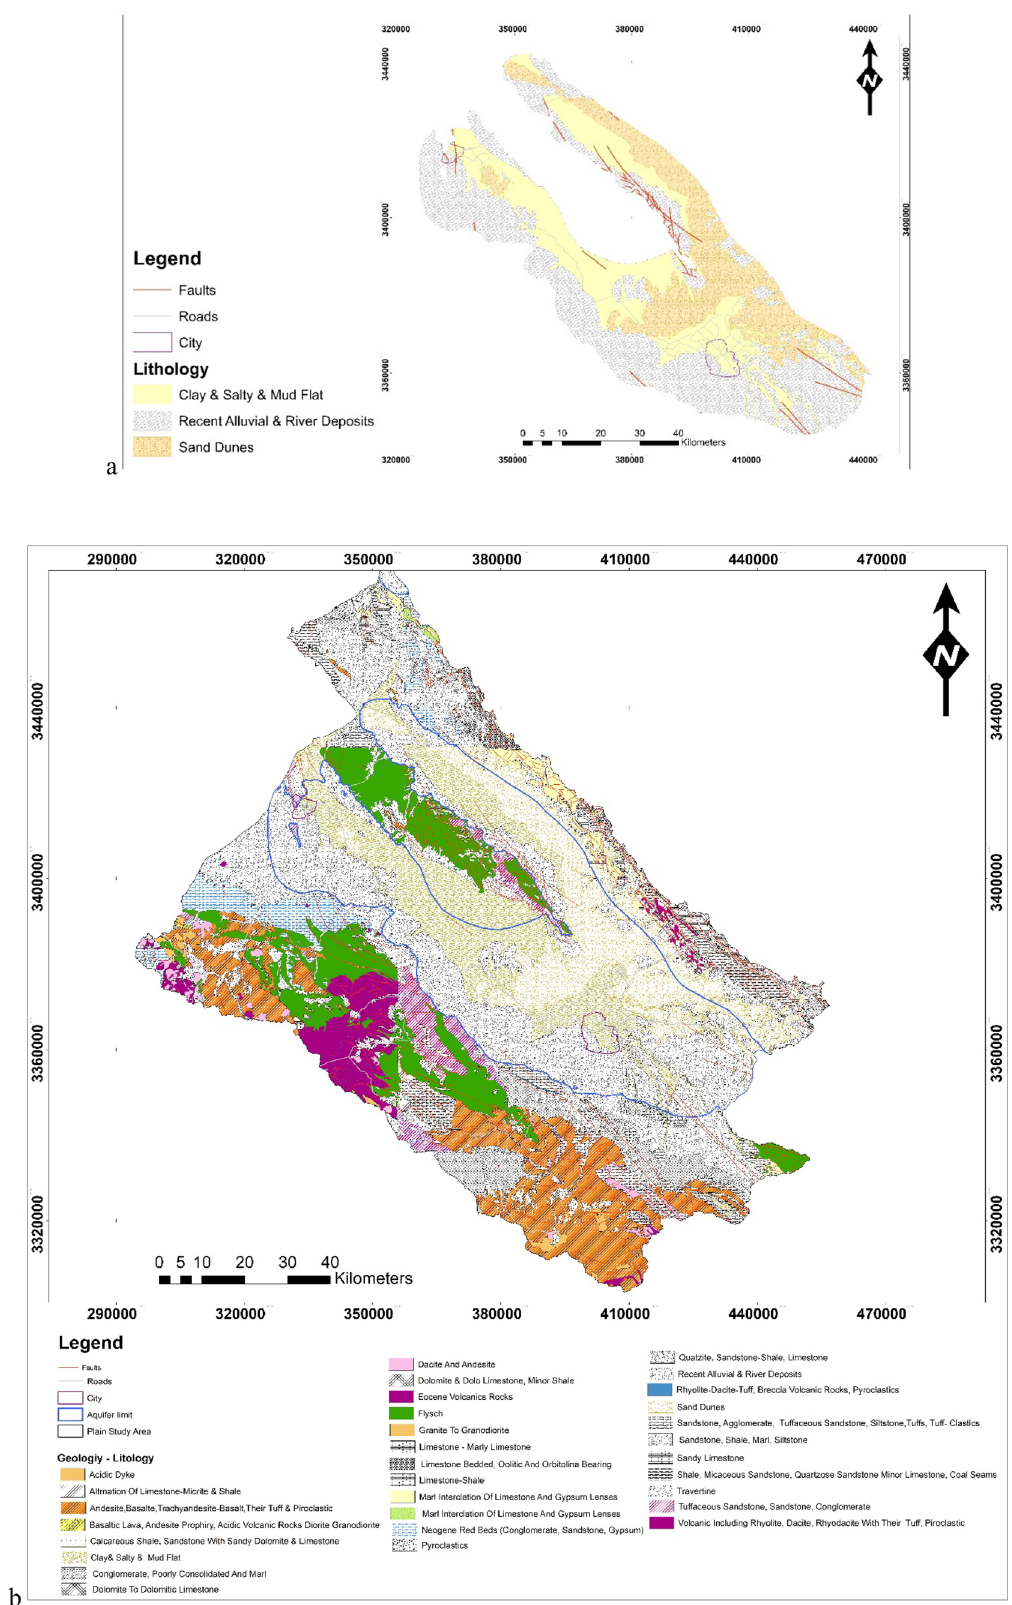
Fig. 2 a Geological setting of the Rafsanjan aquifer and b geological setting of the Rafsanjan